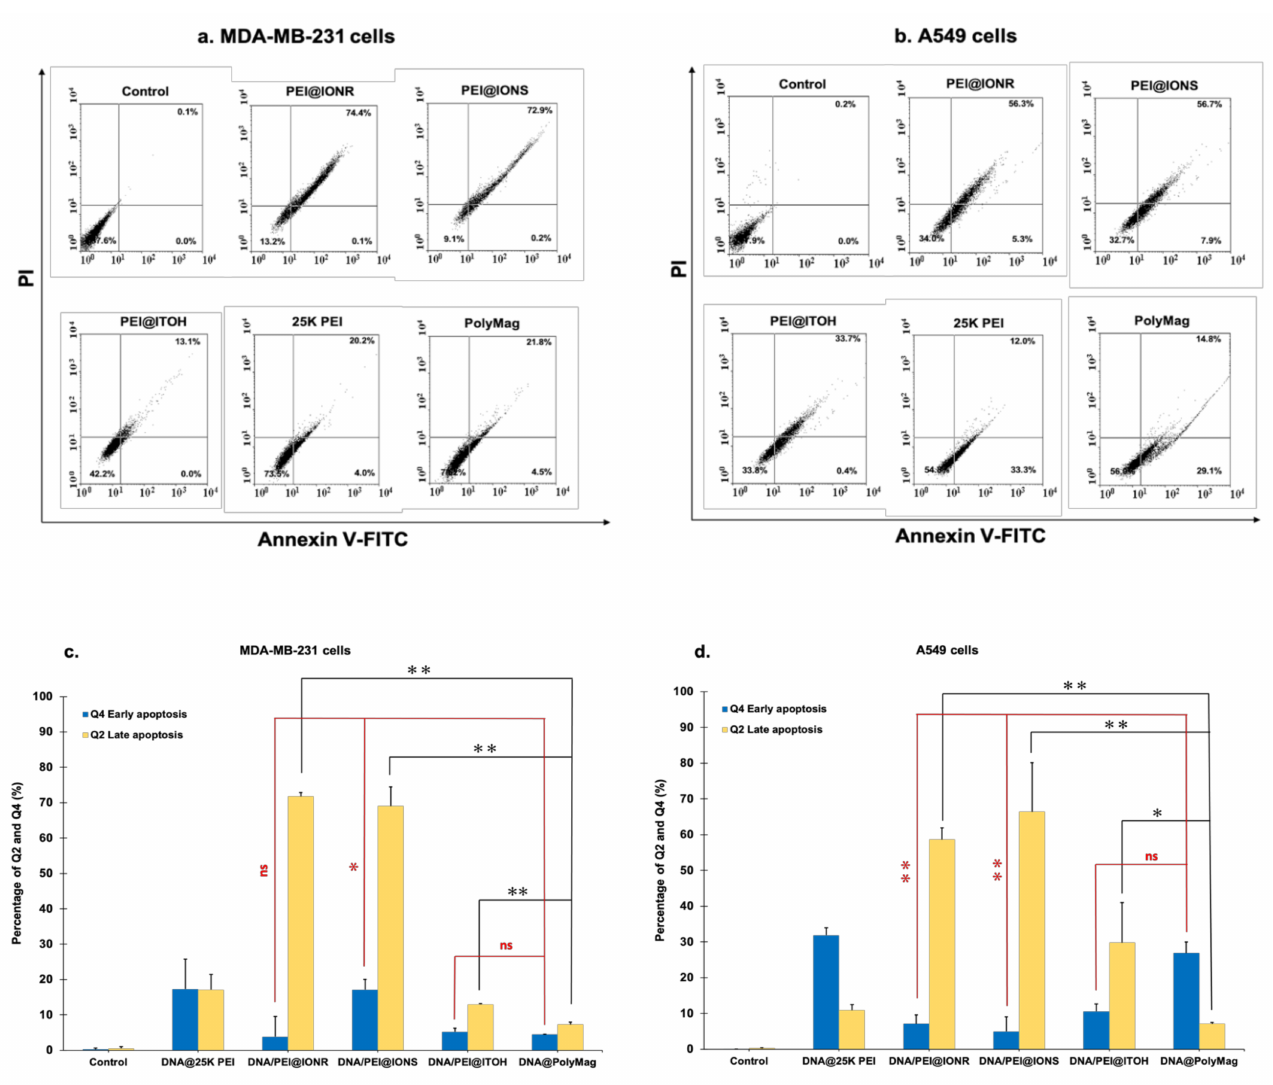
Figure 6. Flow cytometry analysis to study cell apoptosis. After transfection with miRNA34a/PEI@IONPs at a weight ratio of 5 in ( a ) MDA-MB-231 and ( b ) A549 cells, flow cytometry analysis showed that the maximum population of cells was located in late apoptosis quadrant Q2 (the upper right corner), indicating the capability of miRNA34a to induce apoptosis in cancer cells. The quantification of flow cytometry percentages in early apoptosis and late apoptosis was performed after transfection of miRNA34a for 48 hours in ( c ) MDA-MB-231 and ( d ) A549 cell lines and compared to PolyMag as a positive control. The results are represented as mean value ± standard deviation ( n = 3, * p < 0.05, ** p <